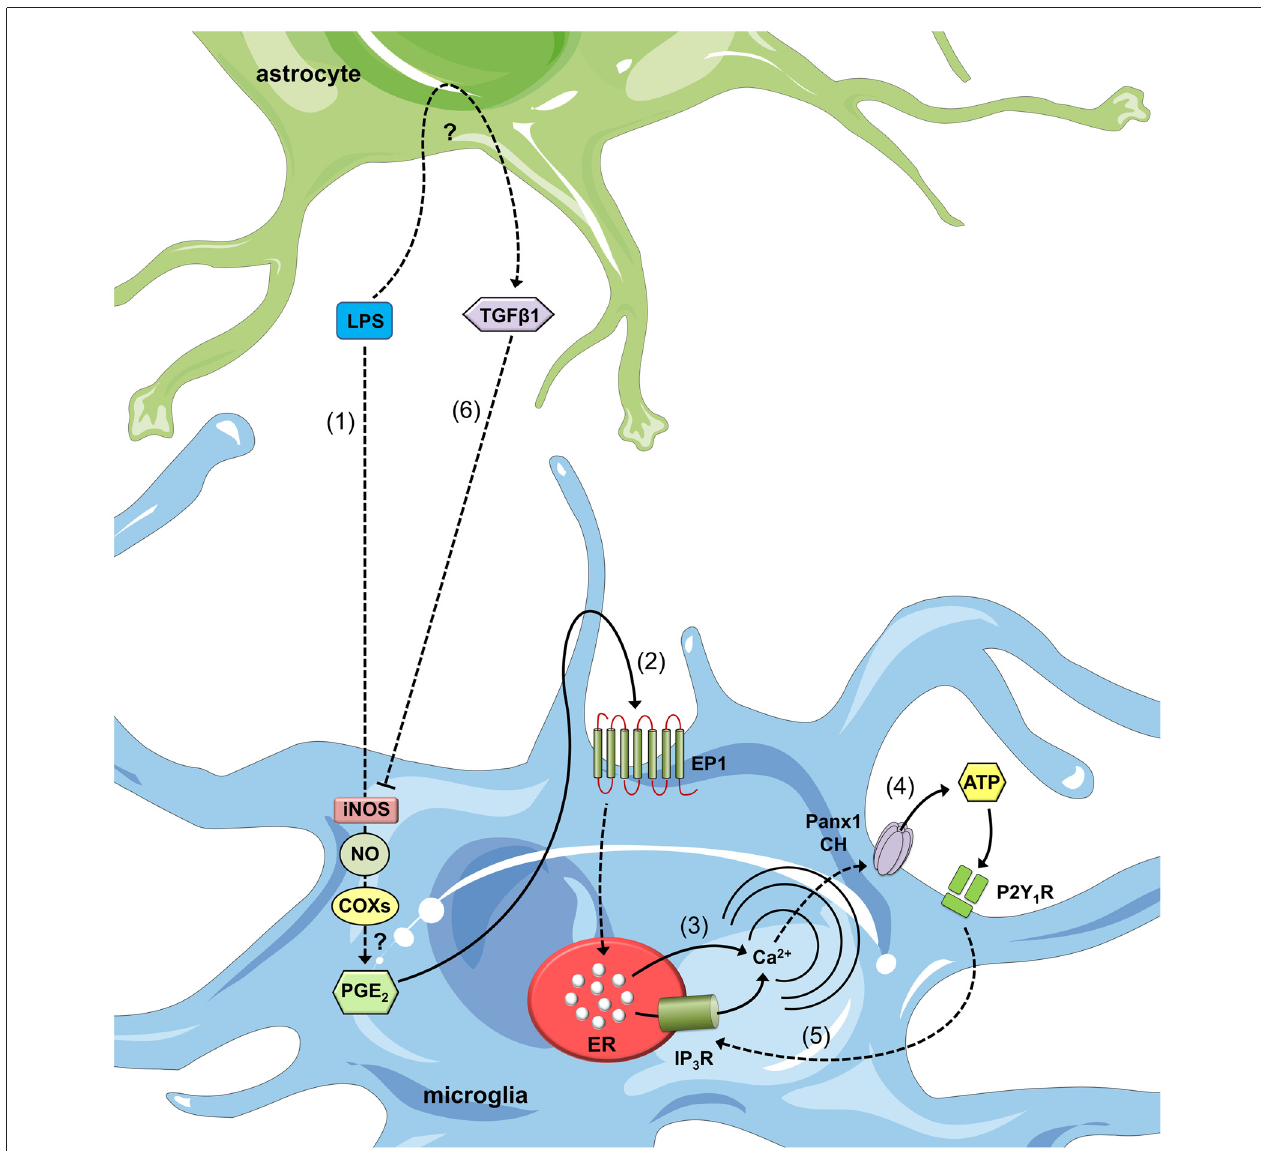
FIGURE 3 | Astroglial modulation of ATP-induced Ca 2 + dynamics in LPS-stimulated microglia. After LPS stimulation, microglia respond with intracellular signal transduction, leading to iNOS activation, nitric oxide (NO) production, cyclooxygenase (COX) activation and prostaglandin E2 (PGE 2 ) production via unknown mechanisms (1). PGE 2 released by microglia binds to the EP1 metabotropic receptor (2) to induce Ca 2 + release from intracellular stores (3). This release increases [Ca 2 + ] i , which is known to open Panx1 channels (CHs) and subsequently release ATP (4). ATP released via Panx1 CHs and its degradation to ADP activate P2Y 1 receptors, which induce IP 3 receptor activation and the further release of Ca 2 + stored in the endoplasmic reticulum (5). Astrocytes stimulated with LPS release transforming growth factor β 1 (TGF β 1) (6), which inhibits LPS-induced intracellular signal transduction and causes iNOS activation. An alternative negative feedback loop mediates the inhibitory effects of ATP on Panx1 channels (not depicted). Finally, paracrine release of ATP from microglia acts upon neighboring or distant microglia, resulting in an additional feed-forward mechanism (not